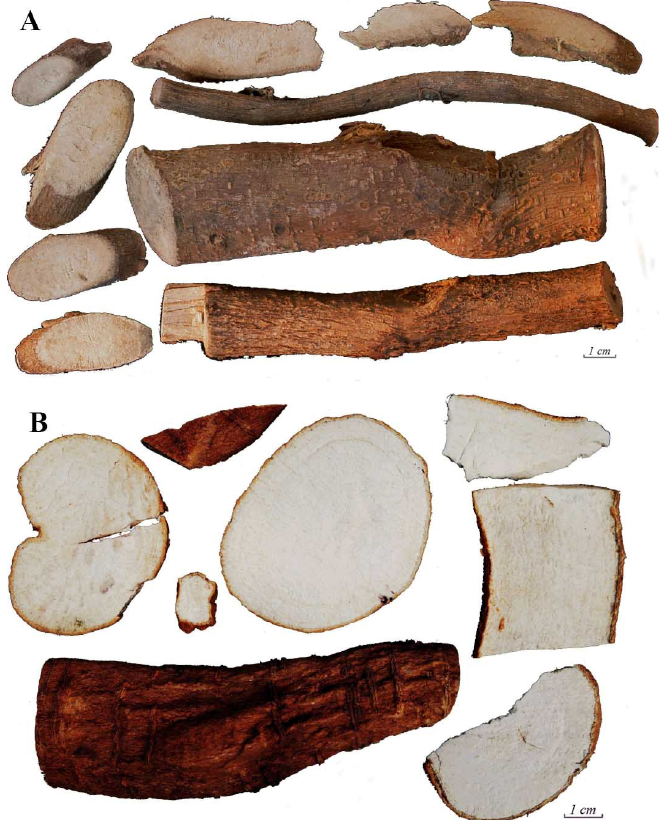
Figure 1. Photographs of Fordiae Cauliflorae Radix ( A ) and Millettiae Pulchrae Radix ( B